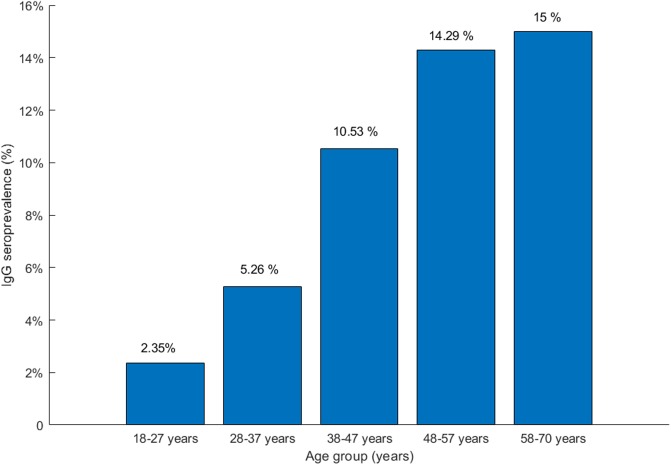
IgG prevalence by age group in French Polynesia.